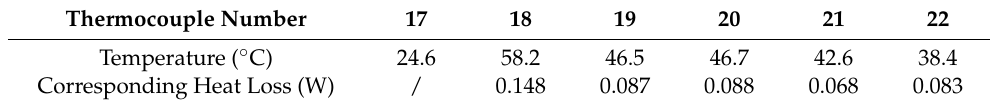
Table 3. Location and function of calibrated